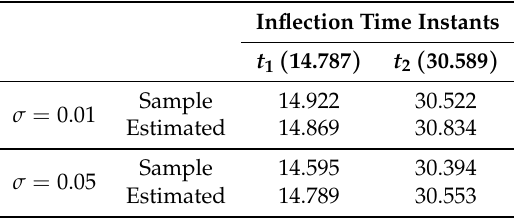
Figure 5. Example 1. Theoretical, sample, and estimated inflection time instants. Table 4. Example 1. Sample and estimated inflection time instants for the model chosen. Theoretical values are in